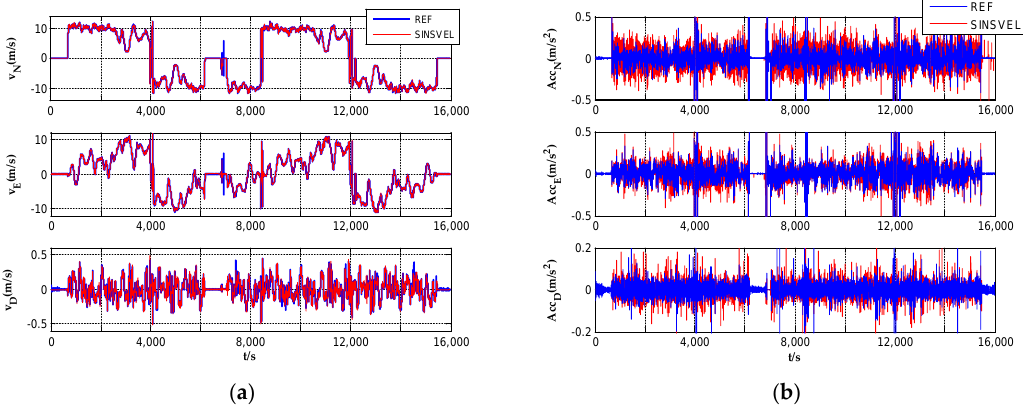
Figure 5. ( a ) Velocity profiles in three directions comparing with the reference in n-frame; ( b ) Acceleration profiles comparing with the reference in n-frame. Sensors 2017 , 17 , 766